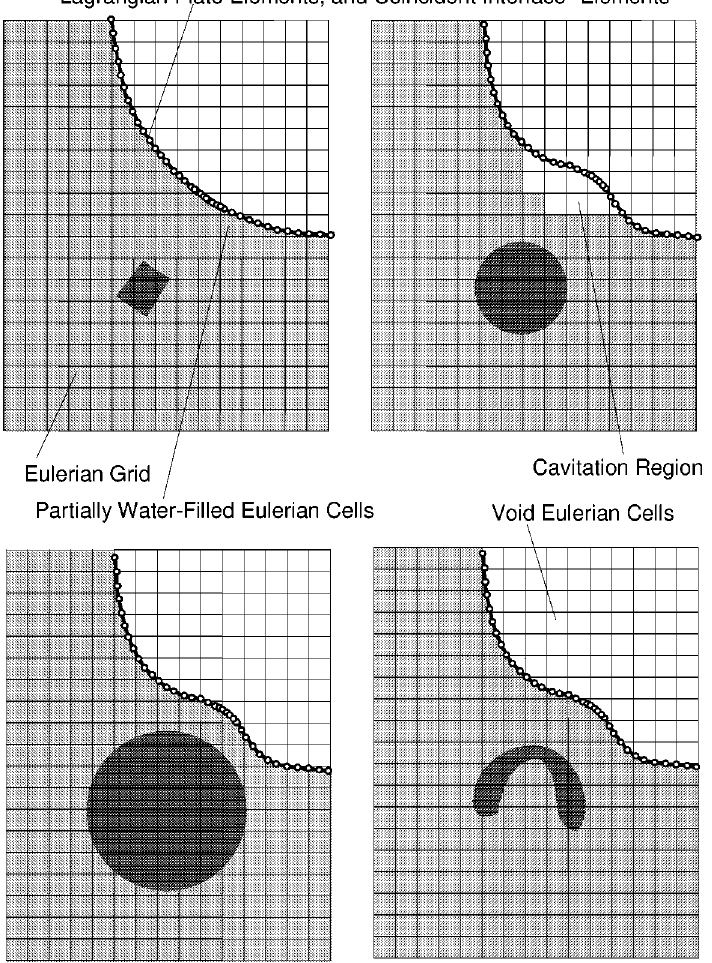
Fig. 6. Coupled Eulerian–Lagrangian hydrocode UNDEX-SMI